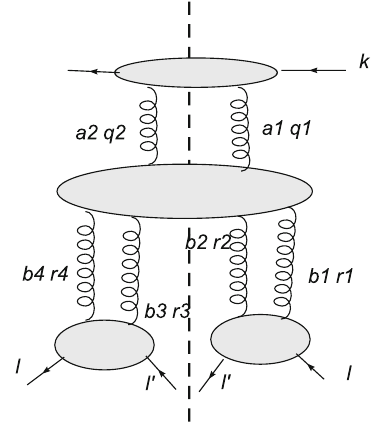
Fig. 5 The diffractive amplitude with two reggeons attached to the projectile